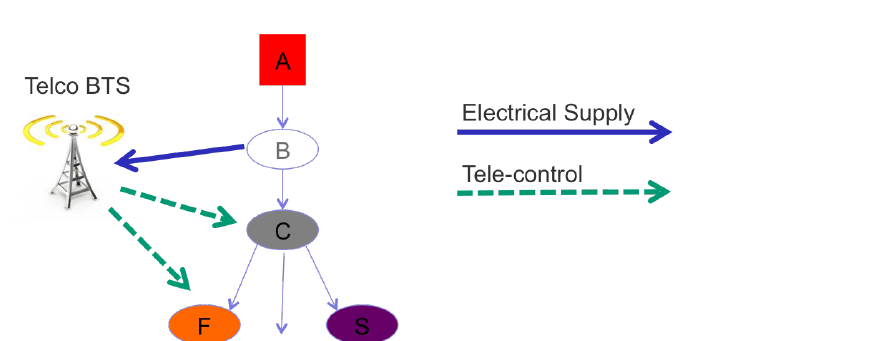
Figure 8. An example of frontier substations.